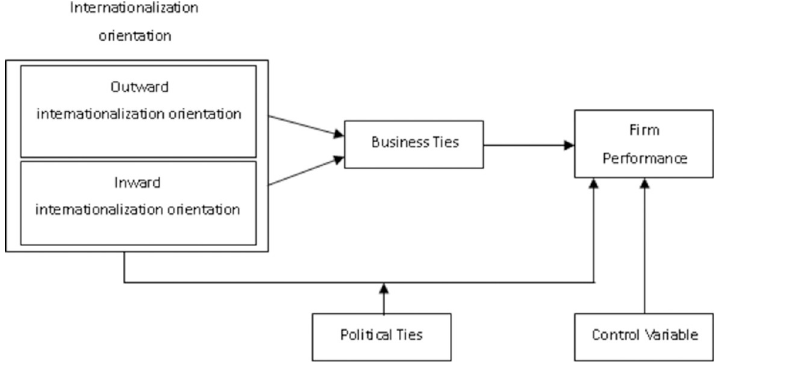
Fig 1. Conceptual model